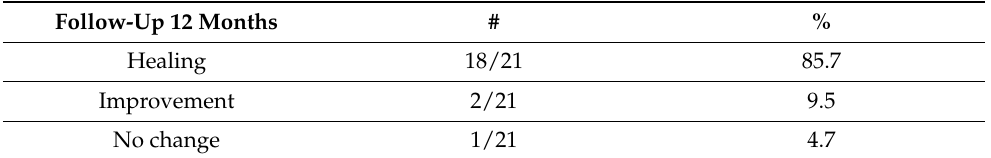
Table 4. Outcome results after 12 months.